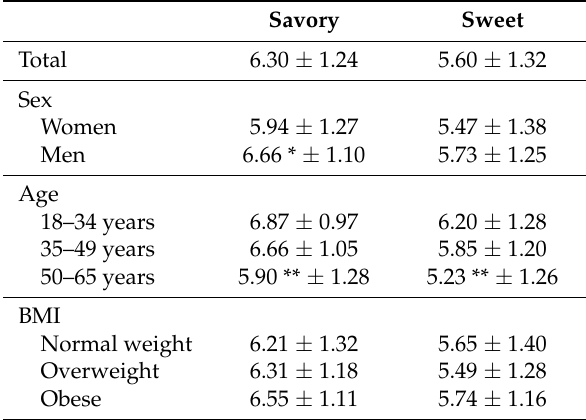
Table 3. Mean liking scores for the total sample, and according to gender, age, and body mass index (BMI).